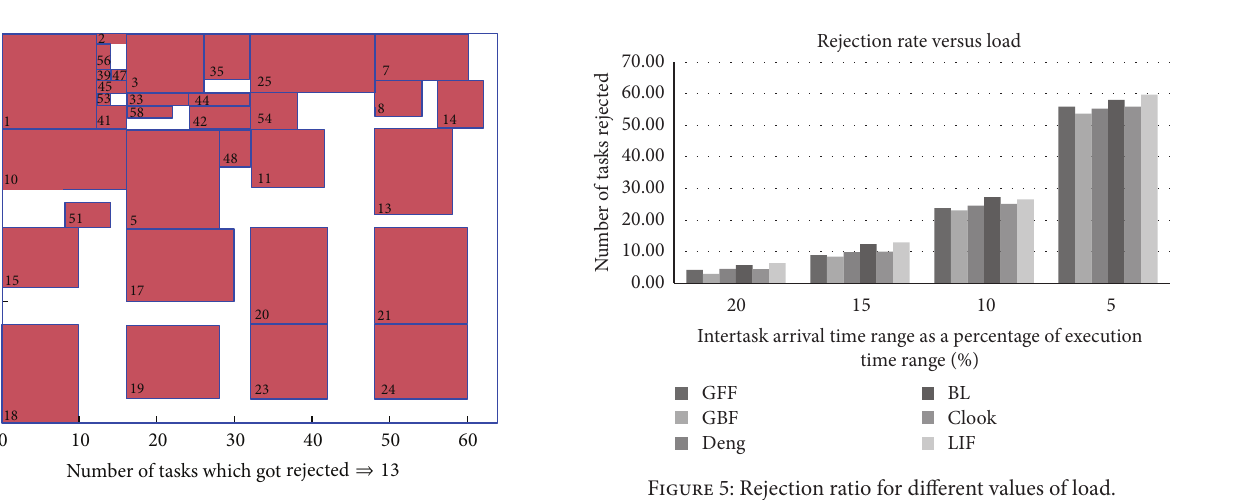
Figure 3: FPGA snapshot while placing tasks.